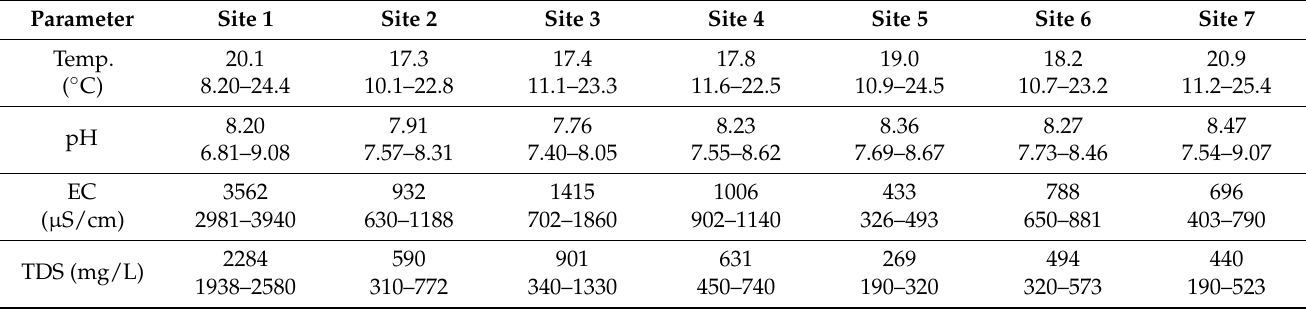
Table 2. Mean, as well as, Min—Max values of physico-chemical parameters and soluble